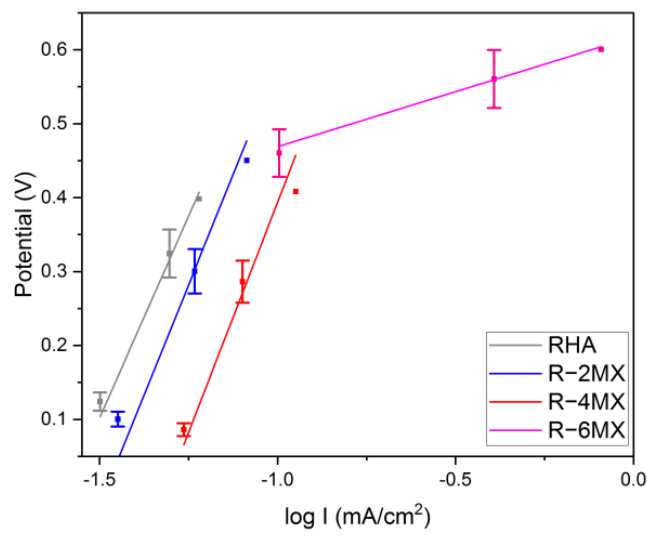
Figure 6. Tafel plot obtained from LSV analysis.